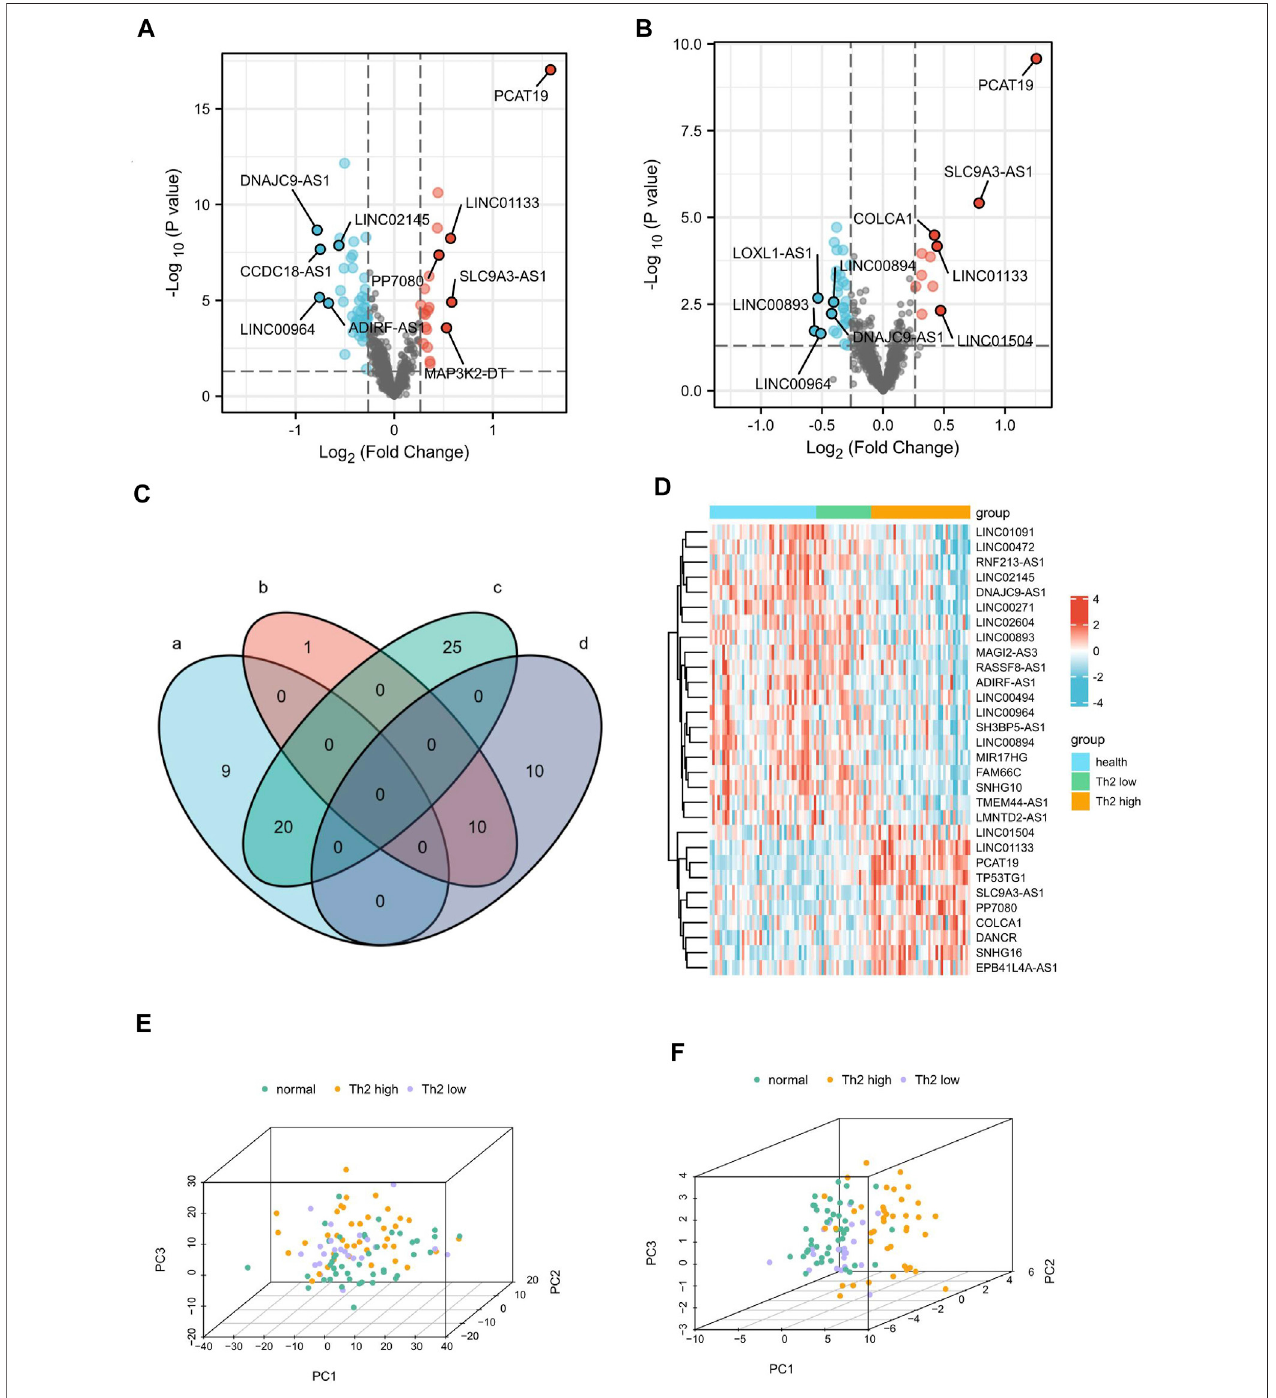
FIGURE 2 | Identi fi cation of 30 DElncRNAs related to Th2 high asthma. (A,B) Volcano plot of the differentially expressed lncRNAs between patients with Th2 high asthma and healthy controls and between patients with Th2 high asthma and Th2 low asthma. The upregulated and downregulated genes with top fi ve ｜ logFC ｜ were marked. (C) A Venn diagram was plotted to identify the upregulated and downregulated DElncRNAs related to Th2 high asthma. (D) The heat map of the expression of the 30 DElncRNAs. (E,F) Principal component analyses of Th2 high asthma, Th2 low asthma, and healthy control groups based on the whole lncRNA and the 30 overlapping DElncRNAs.